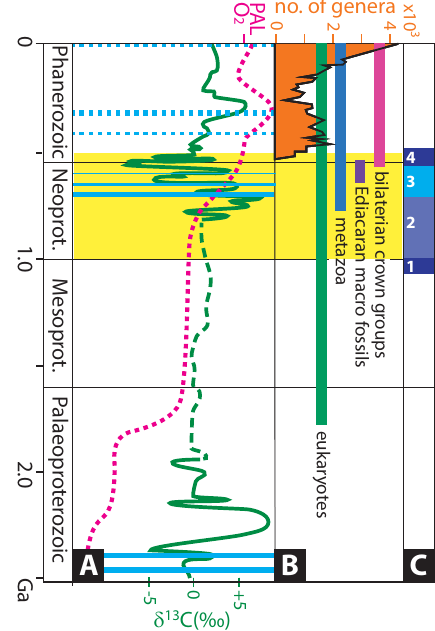
Figure 1. Timeline from the base of the Palaeoproterozoic to present showing the context of the Neoproterozoic to Cambrian rock record targeted for the proposed drilling programme (high- lighted in the yellow band). (a) Generalised δ 13 C and O 2 (rela- tive to present atmospheric level (PAL)) and major ice age peri- ods shown as horizontal blue bands (solid band signifies global- scale glaciation, dashed band indicates high-latitude glaciation; (b) major evolutionary events; and (c) tectonic events related to the Neoproterozoic–Cambrian time slice (1 – Grenville orogeny; 2 – Rodinia Supercontinent; 3 – Rodinia break-up and drift phase; 4 – Pan-African orogeny). See Halverson et al. (2005), Och and Shields-Zhou (2012), and references therein for data